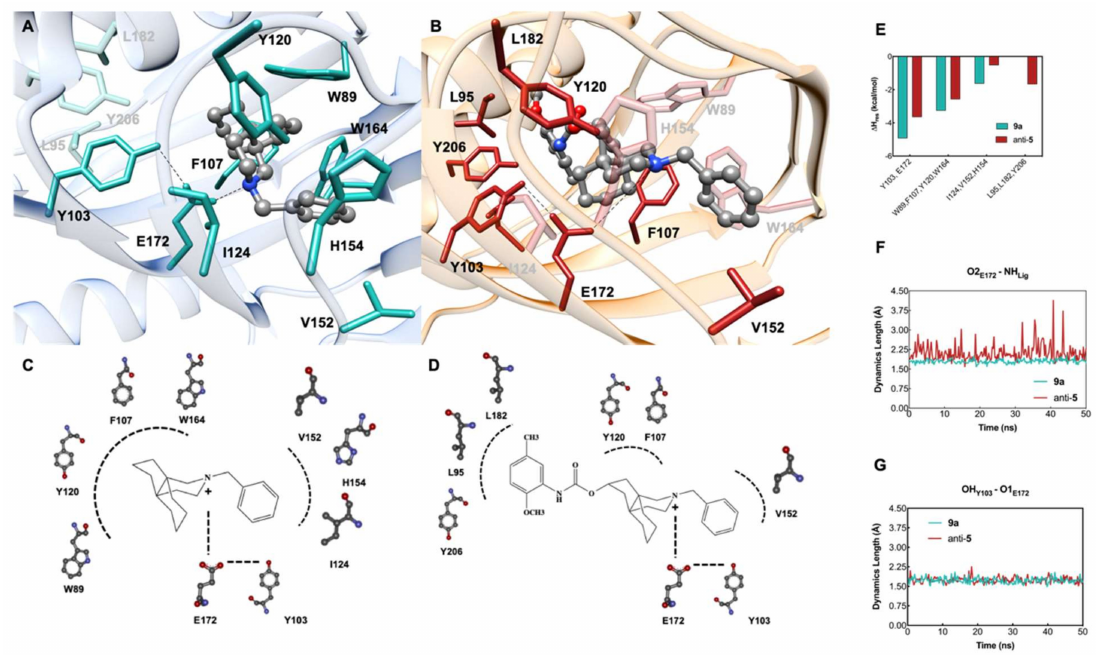
Figure 10. Details of an equilibrated MD snapshot of 9a ( A ) and anti - 5 ( B ) in the binding pocket of σ 1 receptor. The compounds are shown as atom-colored sticks-and-balls (C, grey, N, blue and O, red) while the side chains of σ 1 residues mainly interacting with the ligands are depicted as colored sticks and labeled. Hydrogen atoms, water molecules, ions, and counterions are omitted for clarity. 2D schematic representation of the general stabilizing interactions for σ 1 / 9a ( C ) and σ 1 / anti - 5 ( D ) complexes. ( E ) Per-residue binding free energy decomposition ( ∆ H res ) of the main involved amino acids in σ 1 / 9a (light sea green) and σ 1 / anti - 5 (firebrick) complexes. ( F ) MD distance between the carboxyl oxygen atom (O2) of E172 and the NH group of the ligand detected for σ 1 / 9a (light sea green) and σ 1 / anti - 5 (firebrick) complexes. ( G ) MD distance between the OH group of Y103 and the carboxyl oxygen atom (O1) of E172 detected for σ 1 / 9a (light sea green) and σ 1 / anti - 5 (firebrick)